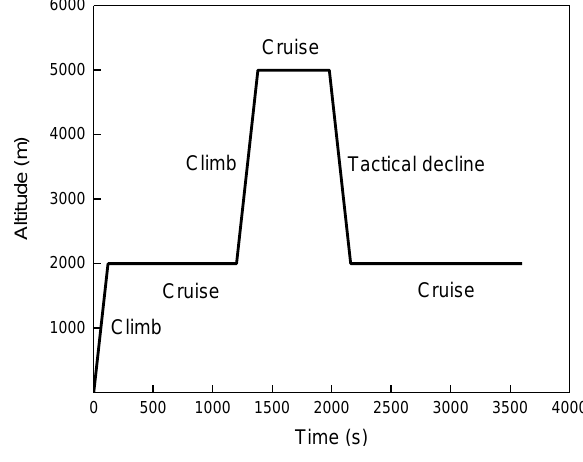
Figure 1. Flight envelope.